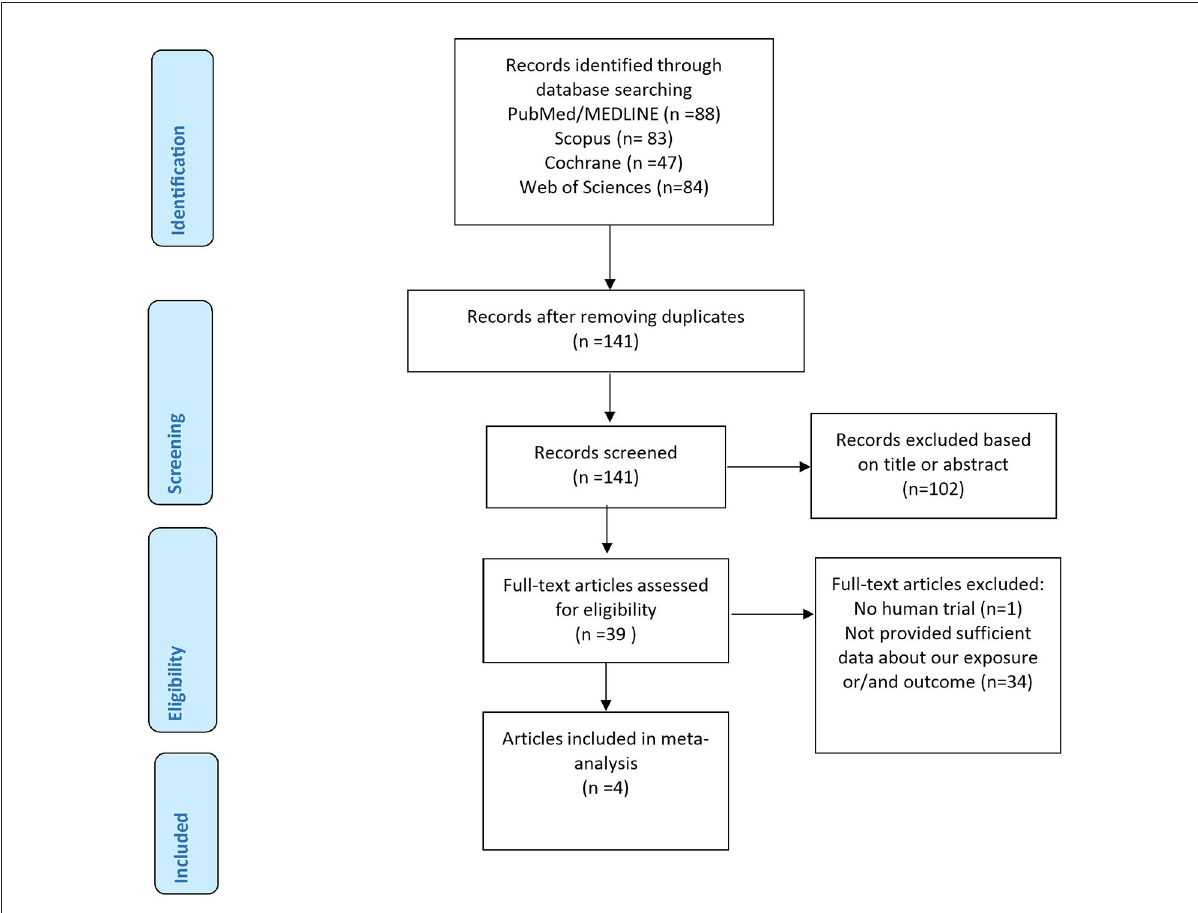
FIGURE1 Flow chart of included